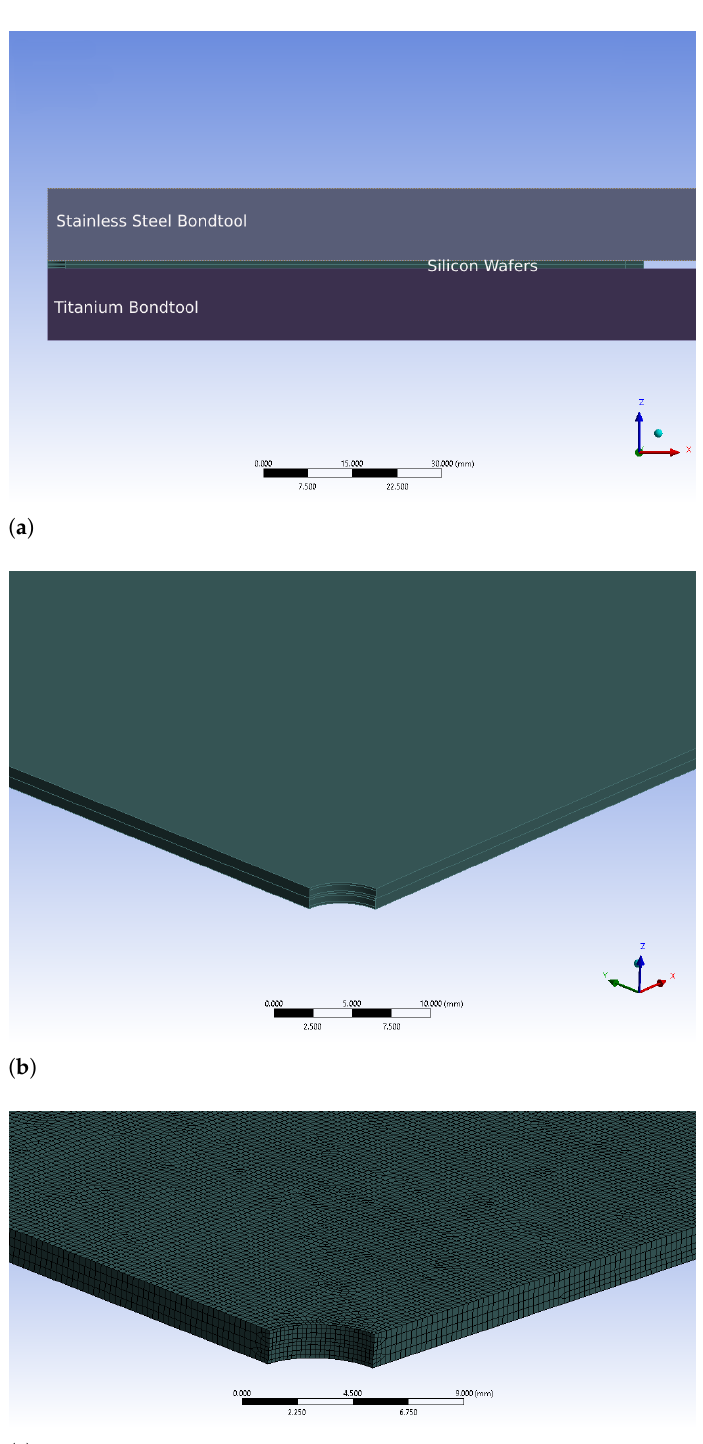
Figure 4. FE model of the geometrical modified silicon wafers under the glass frit bonding process. ( a ) Bonding chamber model configuration; ( b ) Wafers with central hole; ( c ) FE of wafers with central hole